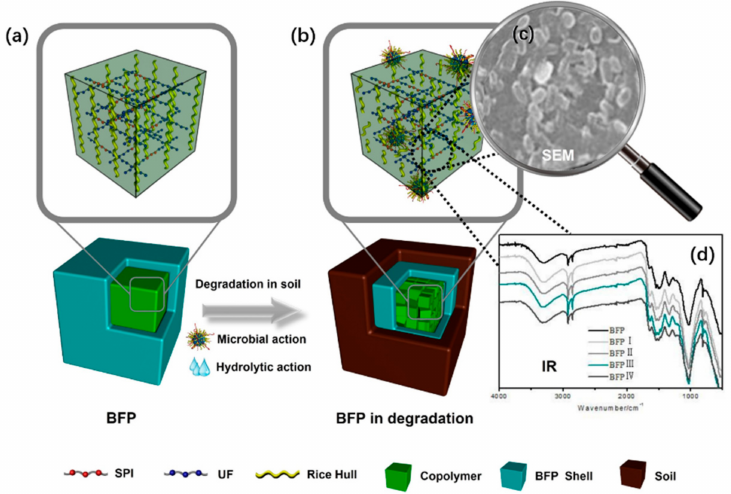
Figure 9. Degrading mechanism of BFP composites. ( a ) Biocomposites prepared by three-dimensional network structure. ( b ) Biodegradable composites under the condition of soil burial environment. ( c ) Abundant microorganisms adhere to the surface of biocomposites. ( d ) Changes of structural groups of degradation